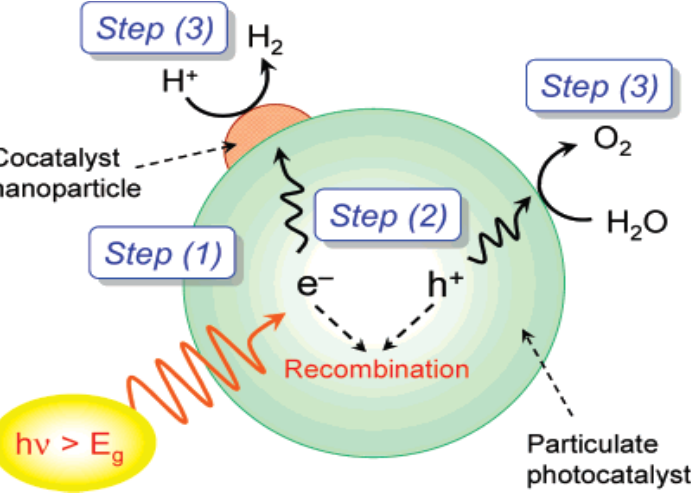
Figure 1. Overall steps involved in the photocatalytic water-splitting process [18].